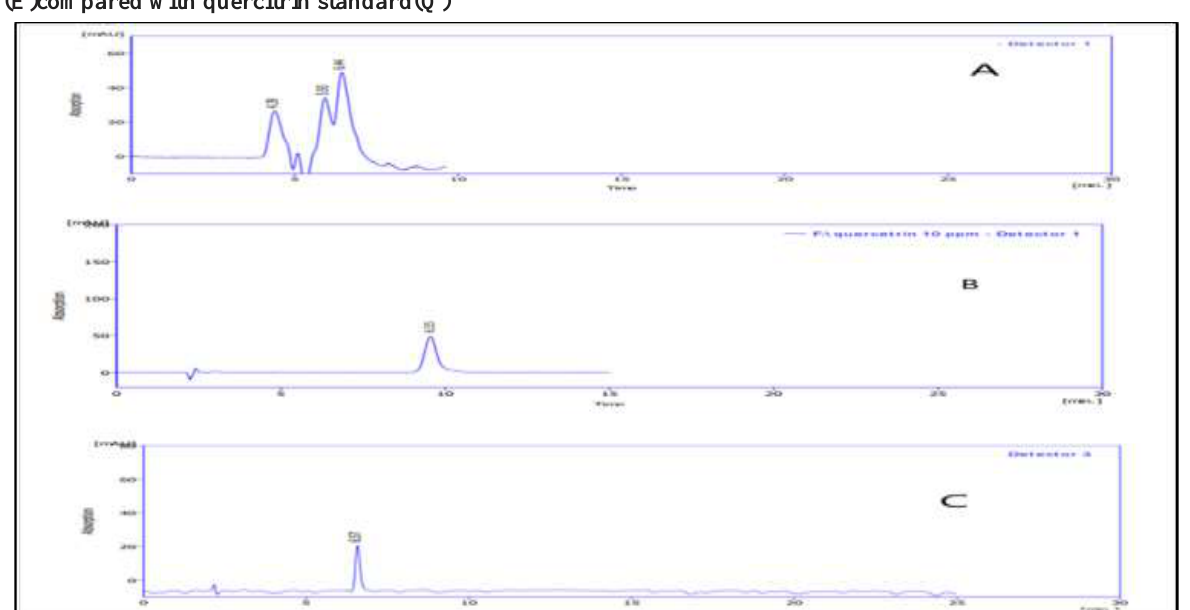
Figure 3. TLC analysis of n. butanol Extract